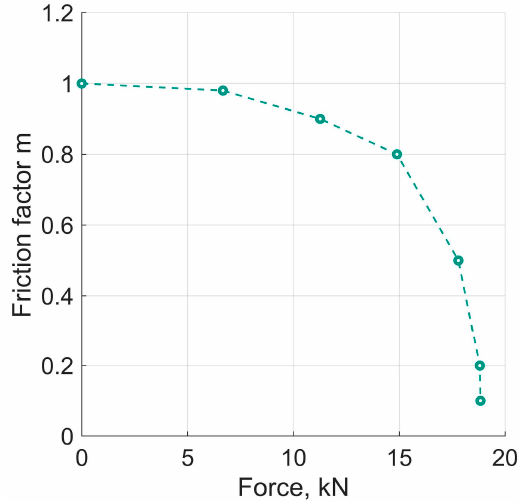
Figure 6. Dependence of the axial force ∆ P at the onset of gripping on the friction factor m.